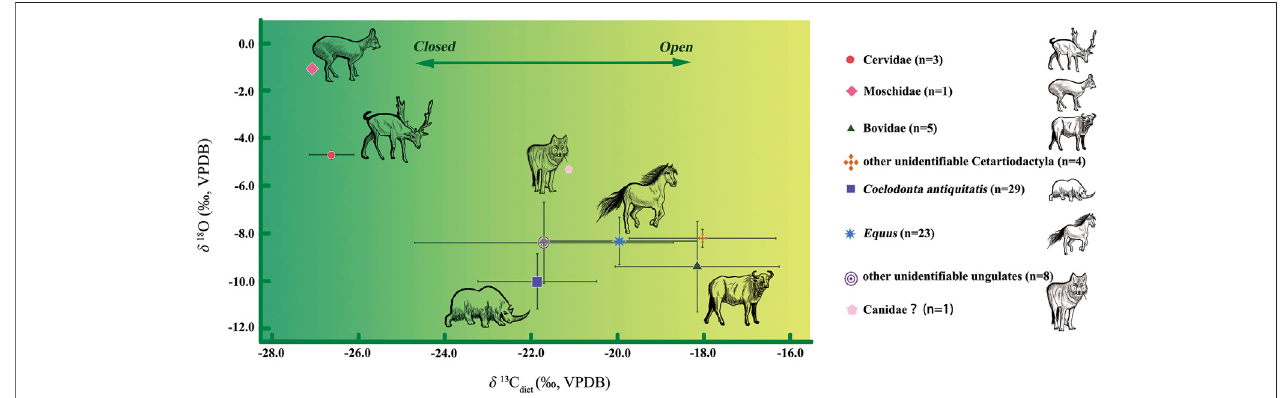
FIGURE 5 | Niche reconstruction of the MDG fossil assemblage, based on δ 13 C diets and δ 18 O enamel values.